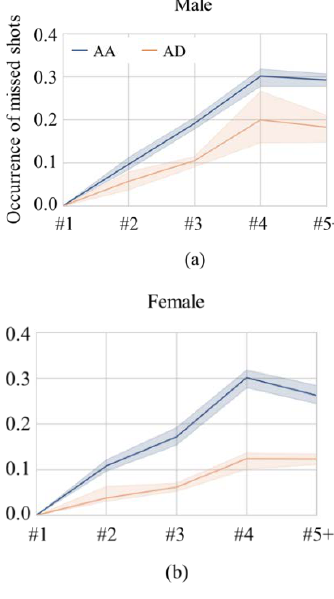
Figure 2 . Occurrence of missed shots at each shot number. “# i ” denotes the i -th shot. The median was calculated for each gender. The shaded area denotes the 95% confidence interval.